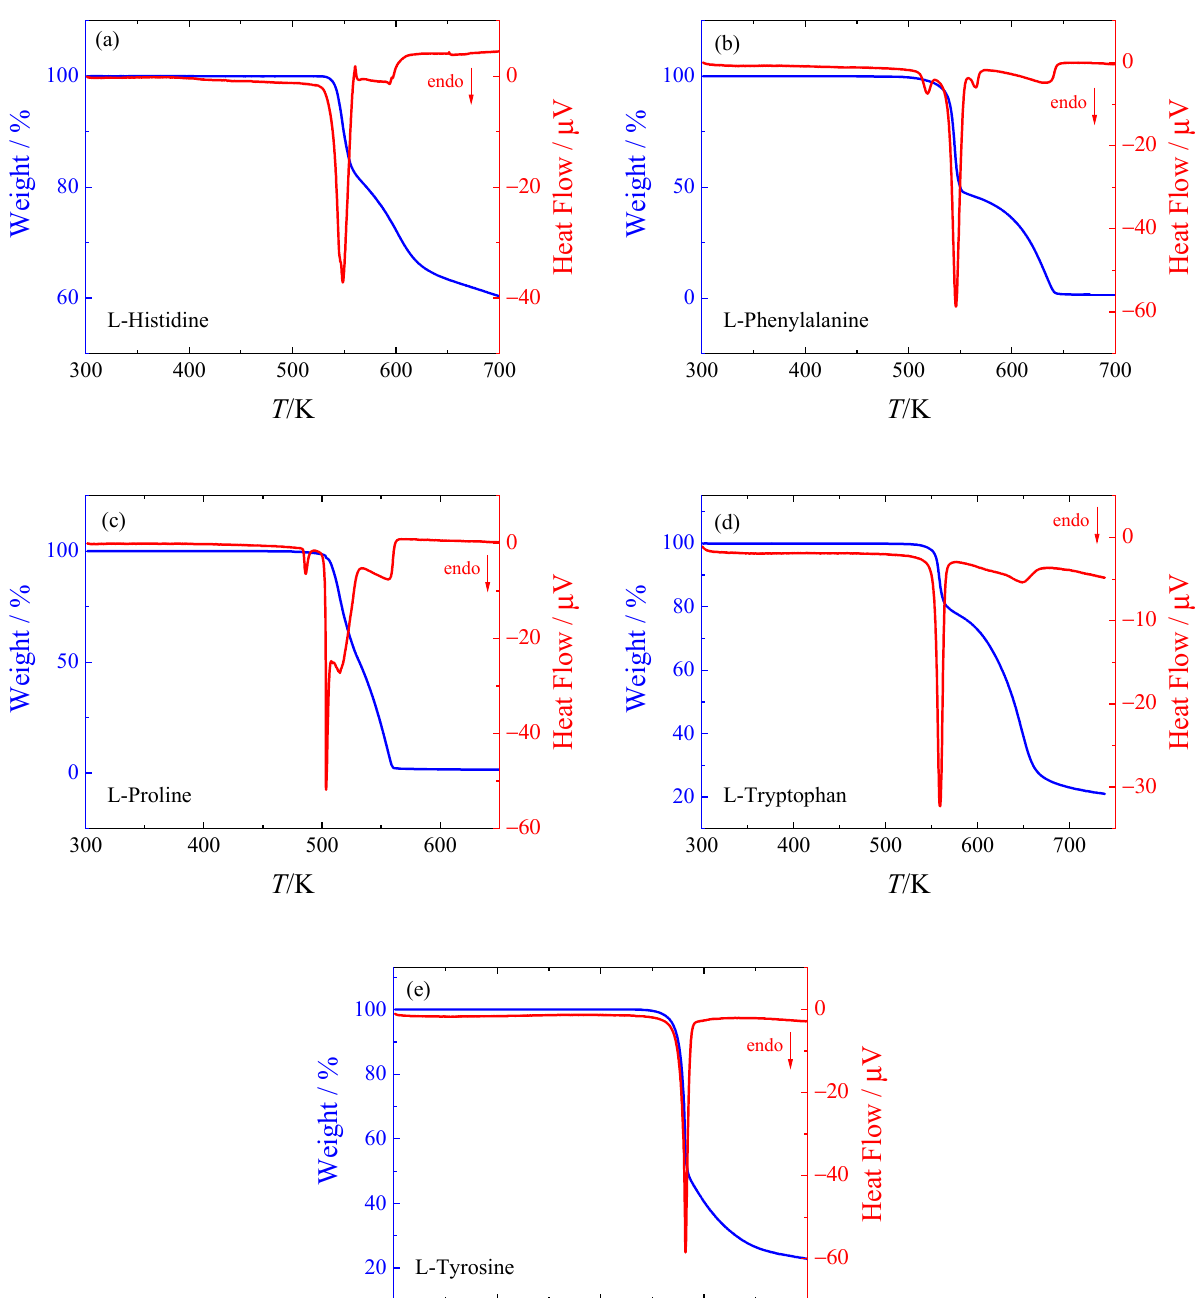
Figure 1. TGA analysis of ( a ) L -histidine, ( b ) L -phenylalanine, ( c ) L -proline, ( d ) L -tryptophan, and ( e ) L -tyrosine.